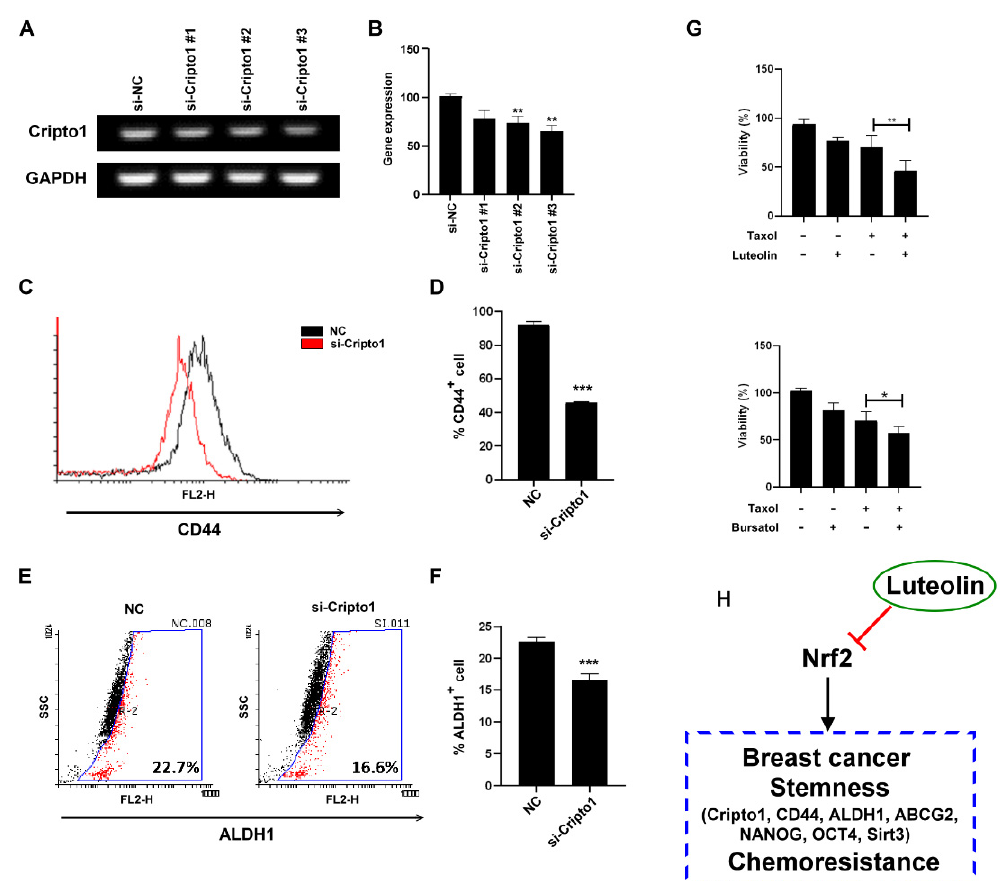
Figure 4. Luteolin inhibited stemness and chemoresistance via Cripto-1 expression: ( A ) a reverse transcription–polymerase chain reaction was conducted to determine the level of Cripto-1 mRNA in cells transfected with Cripto1 small-interfering RNA; ( B ) quantification of Cripto-1 expression in MDA-MB-231 cells; ( C ) CD44 expression in MDA-MB231 cells was analyzed through flow cytometry after Cripto-1 knockdown; ( D ) quantification of CD44 expression; ( E ) ALDH1 + expression in MDA-MB-231 cells was analyzed by flow cytometry after Cripto-1 knockdown; ( F ) quantification of ALDH1 + cells; ( G ) cell viability of MDA-MB-231 subjected to combined treatment with 1 µ M luteolin and 40 nM Taxol for 48 h; ( H ) summary of the mechanisms by which luteolin inhibits triple-negative breast cancer stemness. Student’s t -test: * p < 0.05, ** p < 0.01, *** p < 0.001.